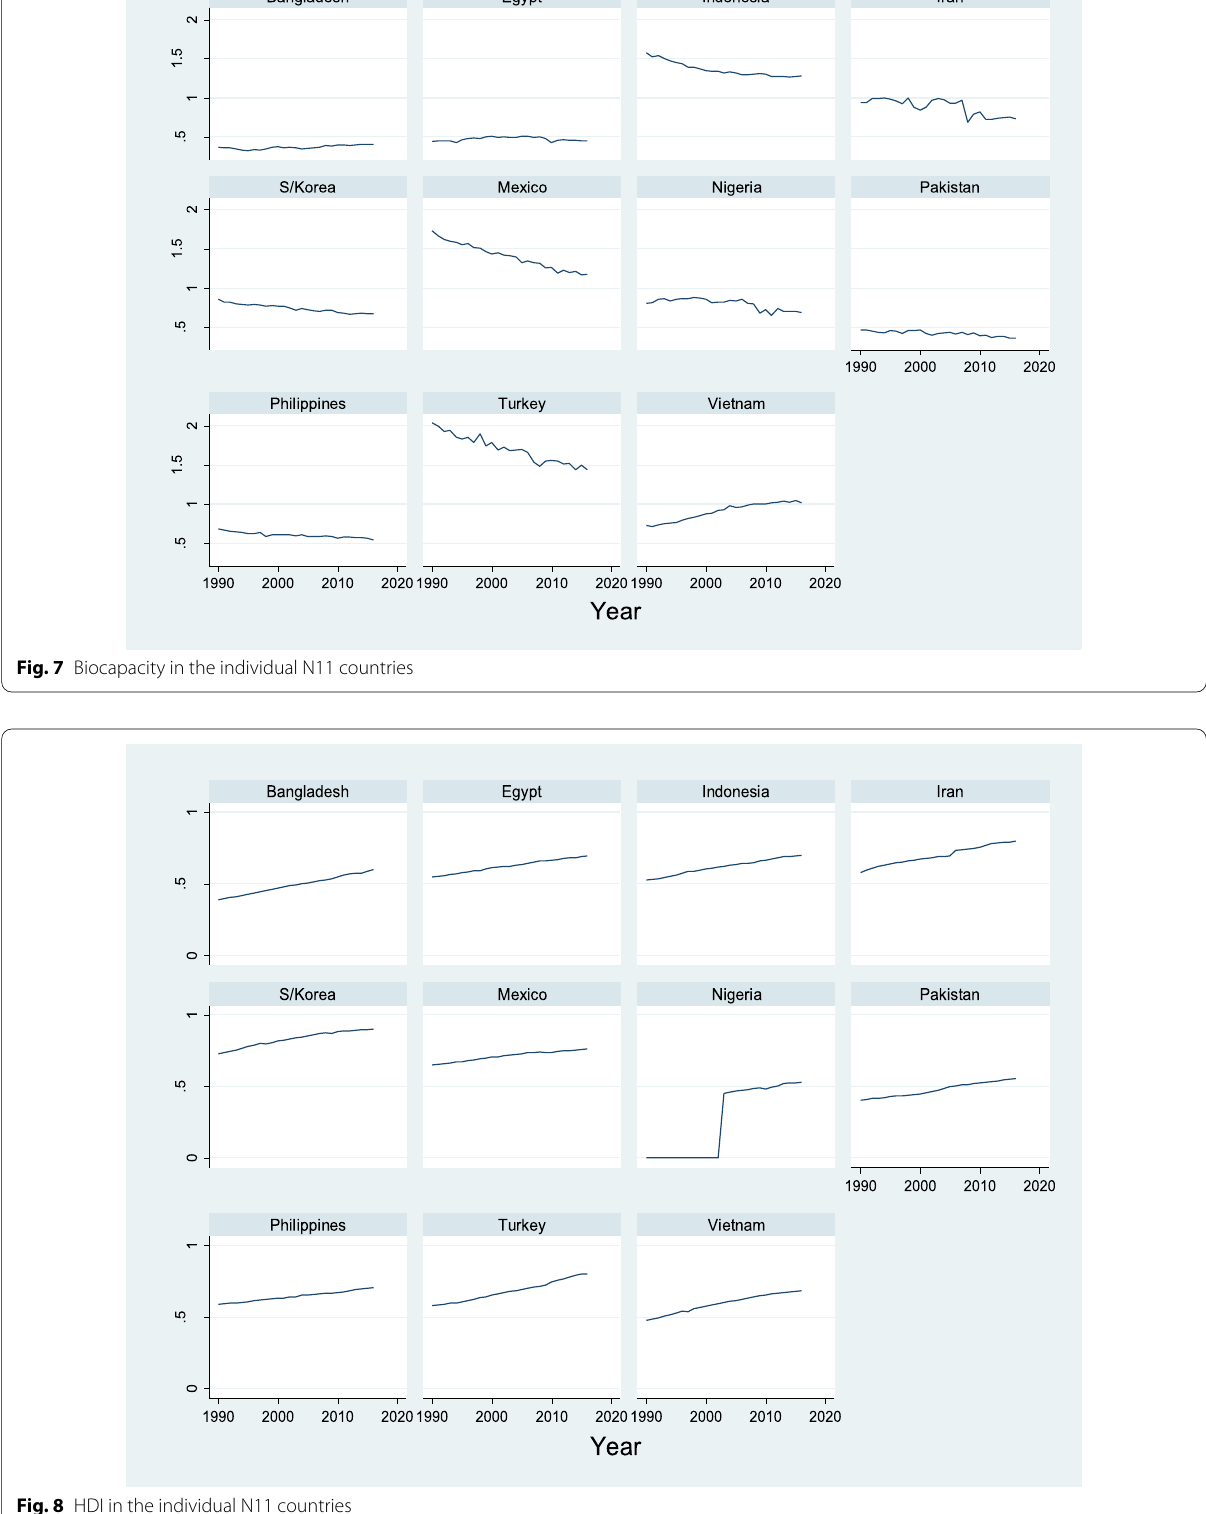
Fig. 8 HDI in the individual N11